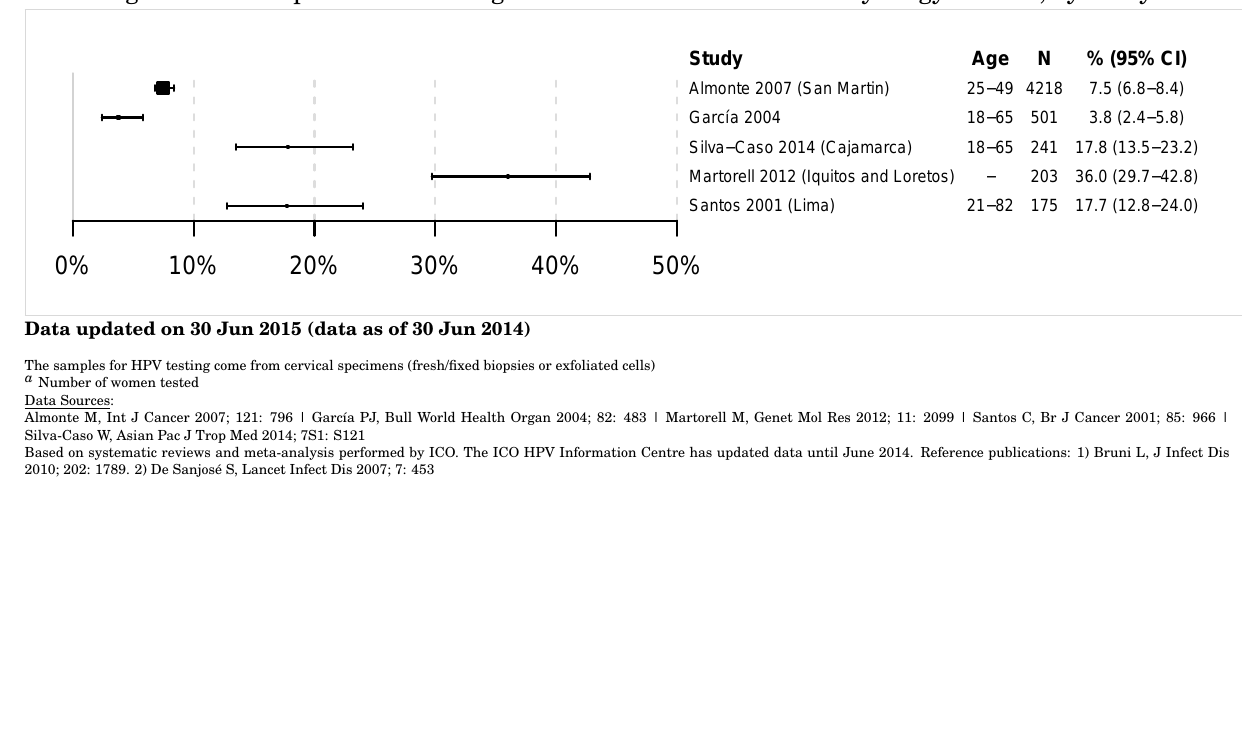
Figure 55: HPV prevalence among women with normal cervical cytology in Peru, by